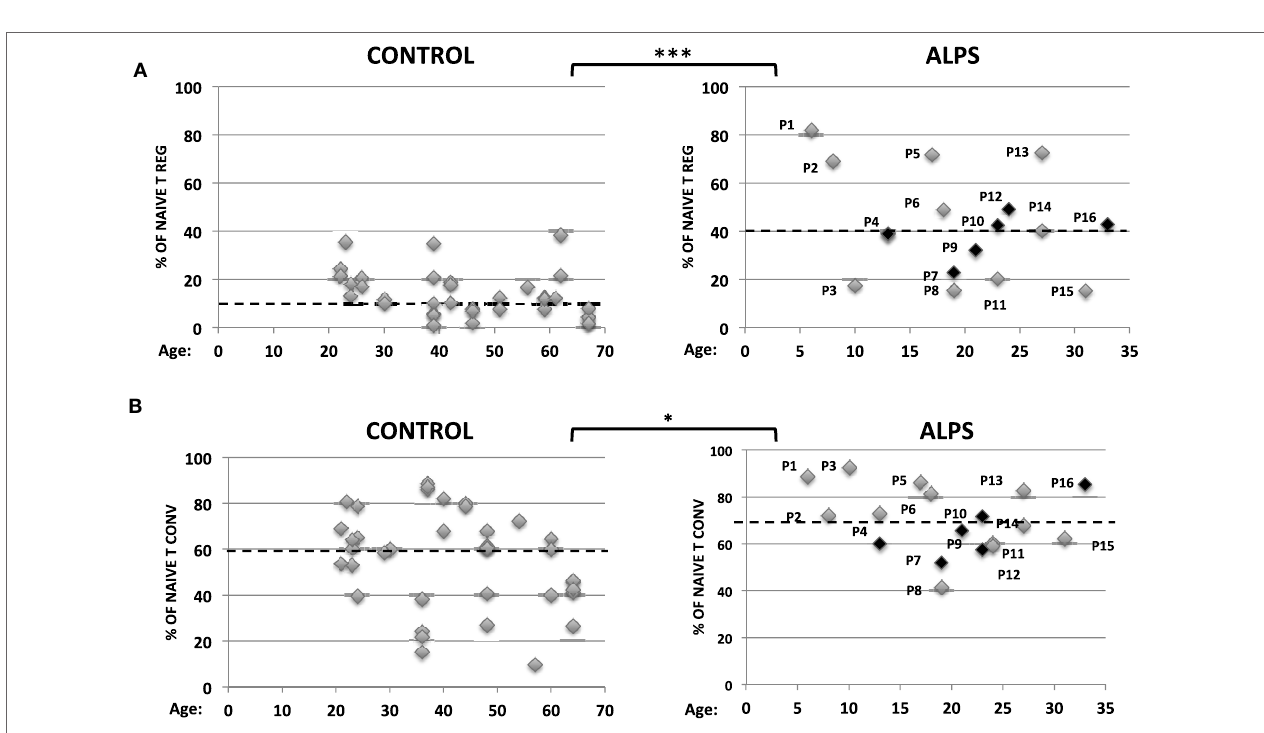
FigUre 2 | Proportions of naïve regulatory T cells (Tregs) and naïve conventional effector T cell (Tconvs) in autoimmune lymphoproliferative syndrome (ALPS) patients. Percentages of CD4 + CD25 + CD127 − CD45RA + naïve Tregs (a) and CD4 + CD25 − CD127 + CD45RA + naïve Tconvs (b) among PBMCs from 16 ALPS patients (right-hand panels) and healthy controls (CTs) (left-hand panels). The year of birth is indicated. For ALPS patients, the year of onset ranged from 2009 to 2014. Patients (P) not having been treated at the time of the assay are indicated in black. The hatched line represents the mean percentage of naïve T cell subpopulations. In panel A, the mean ± SD (range) percentage of naïve Treg was 14.7 ± 1.6% (2–38.3%) for CTs ( n = 25) and 35.3 ± 4.5% (15–82%) for ALPS patients ( n = 16). In panel B, the mean ± SD (range) percentage of naïve Tconvs was 56.5 ± 3.3% (10–88.8%) for CTs ( n = 35) and 70 ± 3.3% (41–92.6%) for ALPS patients ( n = 16). Statistical analyses were performed using a non-parametric Mann–Whitney U -test (*** p < 0.0001; * p =